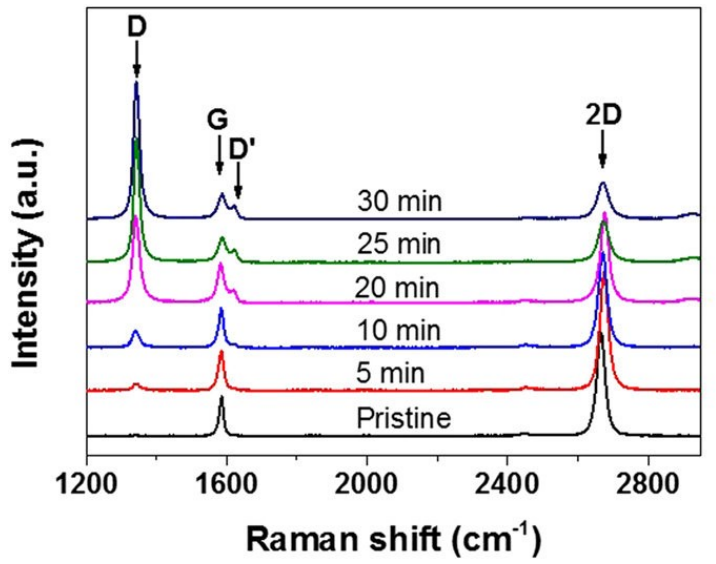
Figure 7. Raman spectra of pristine graphene and BPO-functionalized graphene heated at 80 °C for 5 min, 10 min, 20 min, 25 min and 30 min in nitrogen atmosphere, respectively. Adopted from [159] (CC BY).